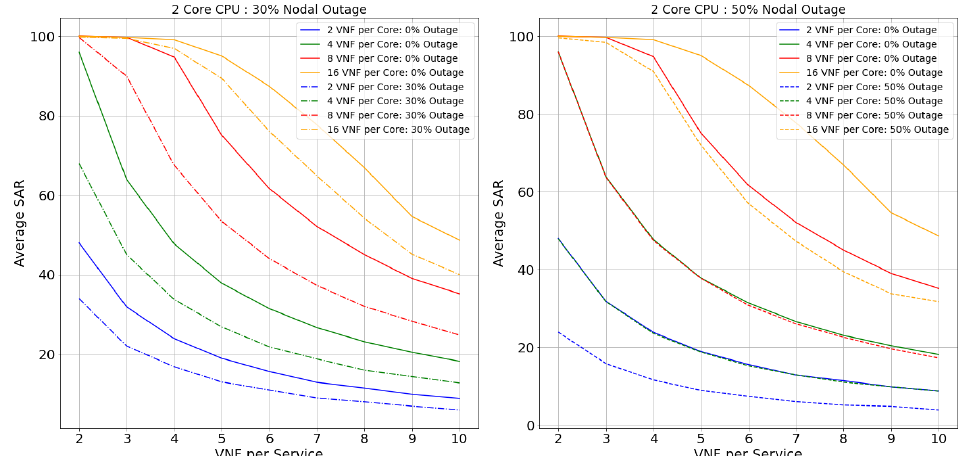
Figure 17. SAR: BtEurope topology with nodal outage—2 core CPU.